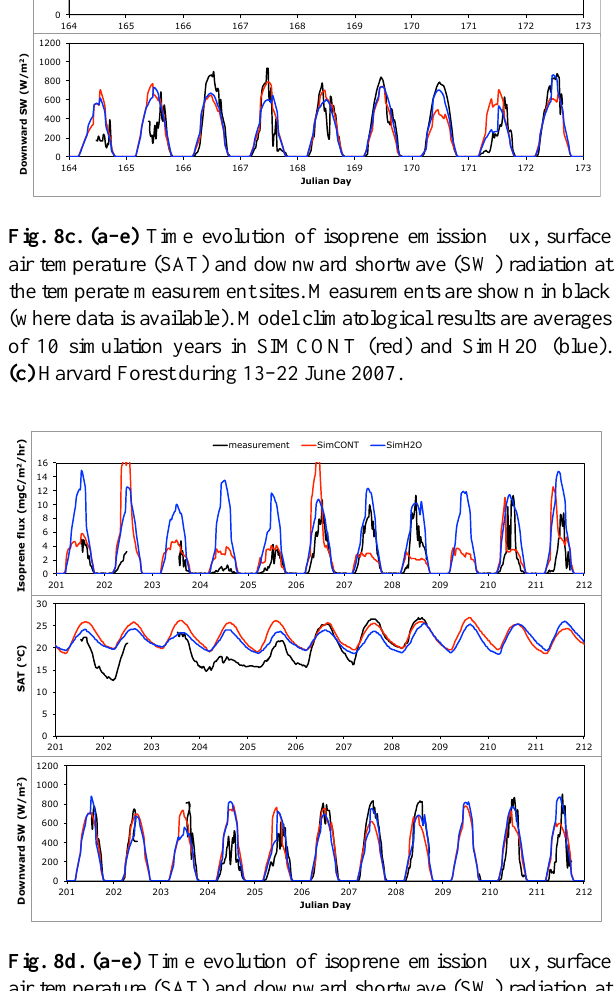
Figure 8b. Results for Montmeyan during June 11 – 27 2001. Fig. 8b. (a–e) Time evolution of isoprene emission flux, surface air temperature (SAT) and downward shortwave (SW) radiation at the temperate measurement sites. Measurements are shown in black (where data is available). Model climatological results are averages of 10 simulation years in SIMCONT (red) and SimH2O (blue). (b) Montmeyan during 11–27 June 2001.